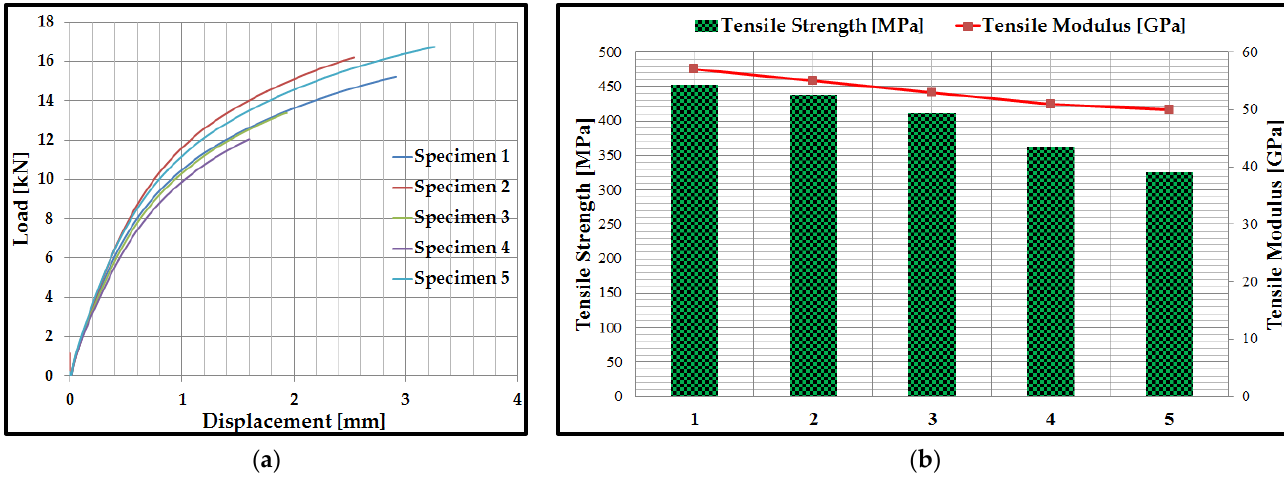
Figure 7. The results of tensile tests: ( a ) load–displacement curves of the specimens; ( b ) Tensile strength and tensile modulus of specimens.